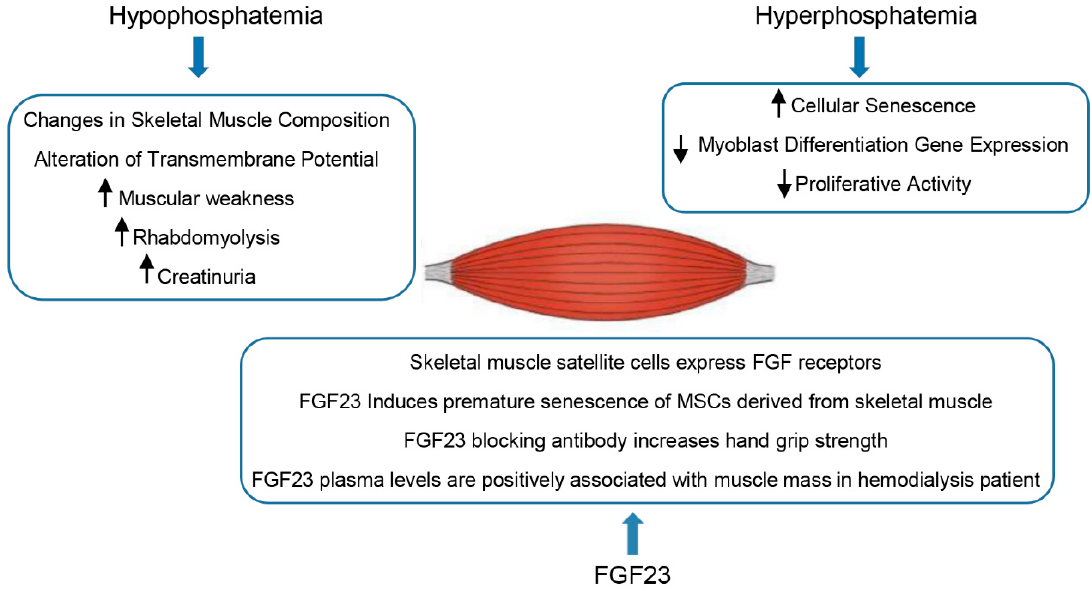
Figure 2. Effects of hypo- and hyper-phosphatemia and FGF23 on skeletal muscle.